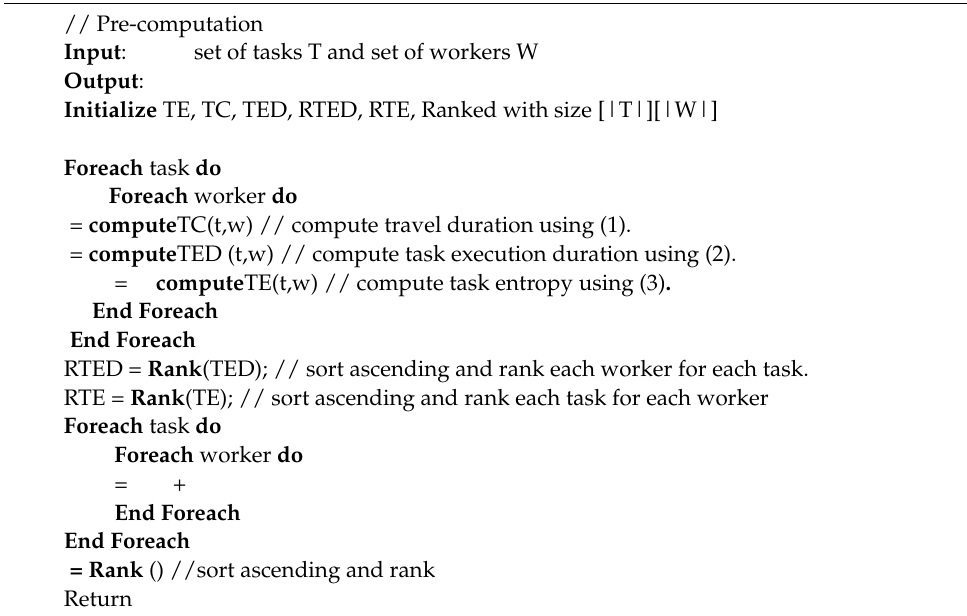
Algorithm 1. Pseudo code for algorithm